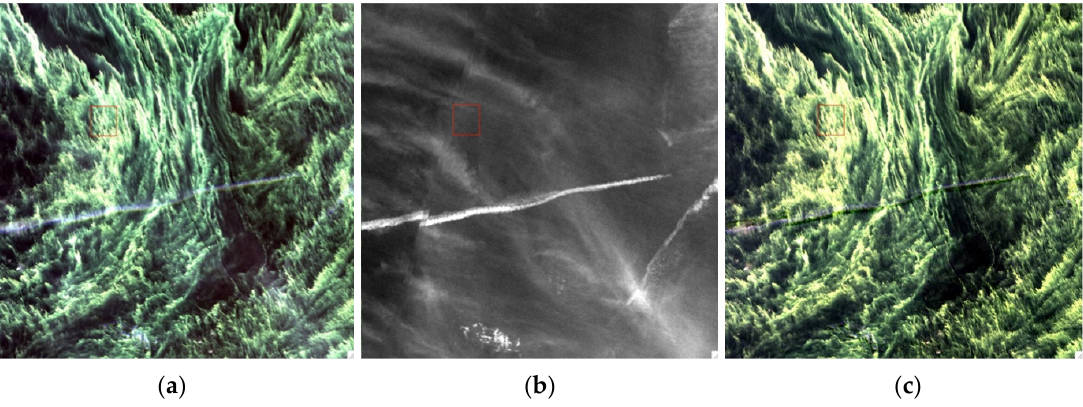
Figure 9. ( a ) A Landsat 8 OLI RGB image acquired over Baltic Sea on 11 August 2015 during a chlorophyll bloom; ( b ) The Band 9 (cirrus) image; ( c ) The cirrus-corrected RGB image.